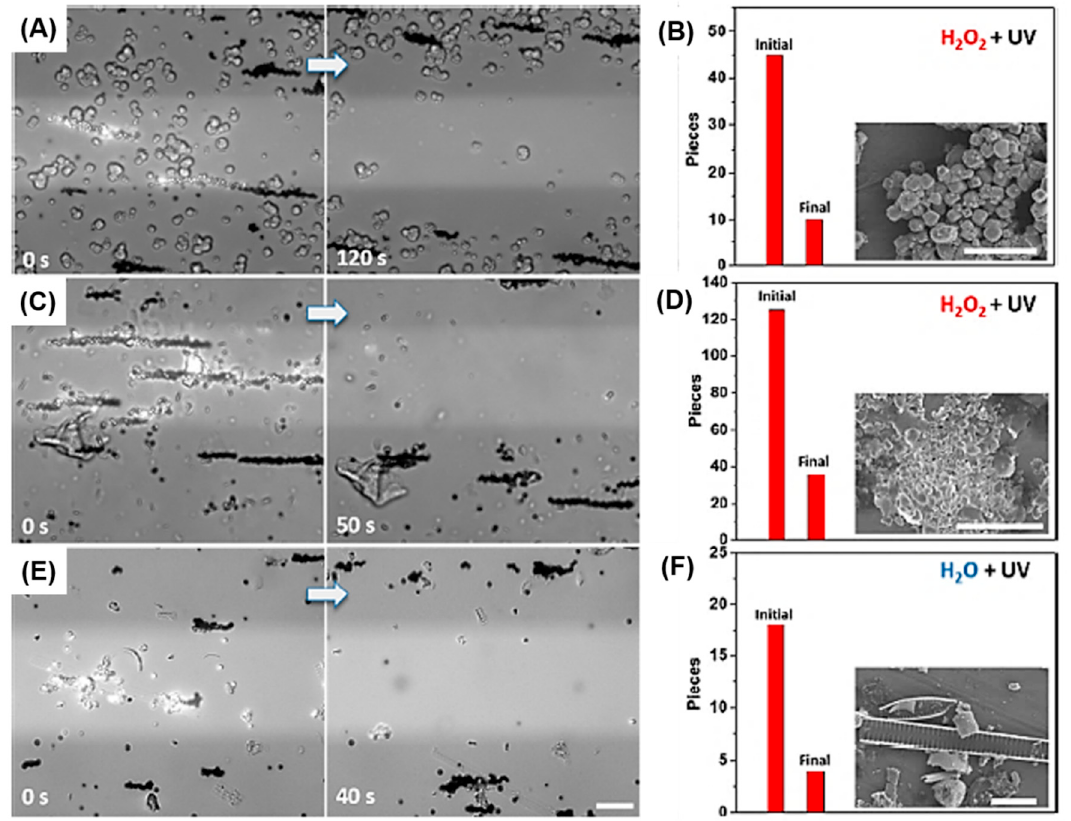
Figure 6. Captured images of the removal of different microplastics (MPs) using magnetic Au@Ni@TiO 2 under a magnetic field: ( A ) washing powder sample in 0.1% H 2 O 2 under 63 mW